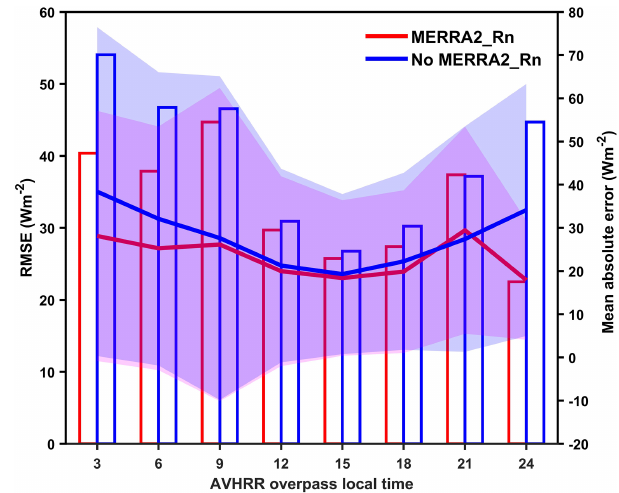
Figure 14. Effect of daily mean MERRA-2 R n on AVHRR R n re- trievals at different satellite crossing times in local time over sites. The bars indicate RMSE, and lines indicate absolute biases. The shading shows the variation range of absolute